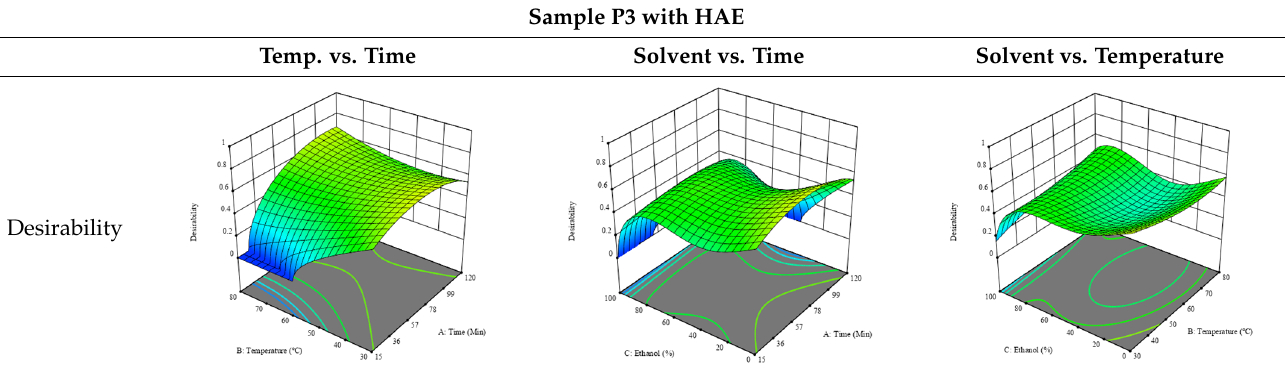
Sample P3 with HAE